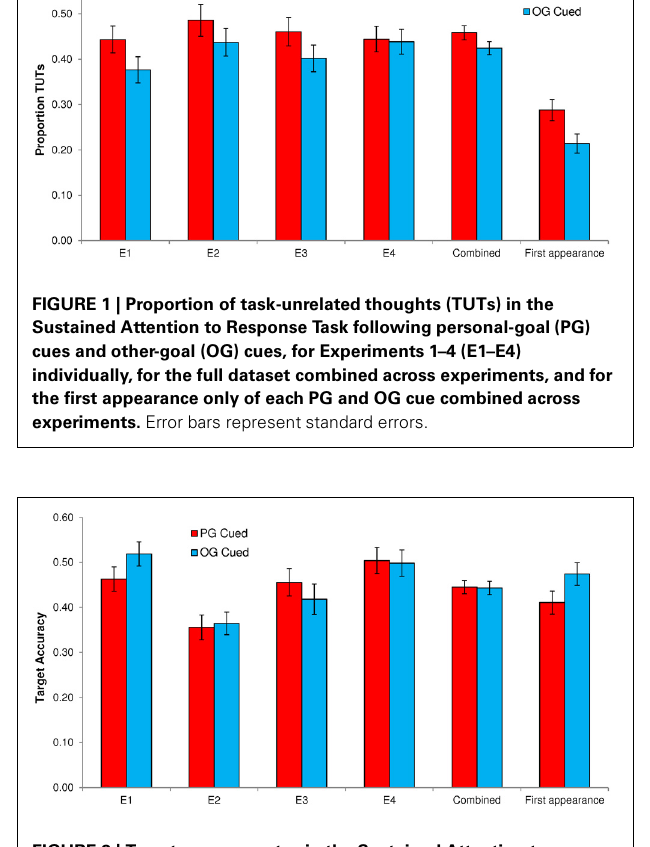
FIGURE 2 | Target accuracy rates in the Sustained Attention to Response Task following personal-goal (PG) cues and other-goal (OG) cues, for Experiments 1–4 (E1–E4) individually, for the full dataset combined across experiments, and for the first appearance only of each PG and OG cue combined across experiments. Error bars represent standard errors.